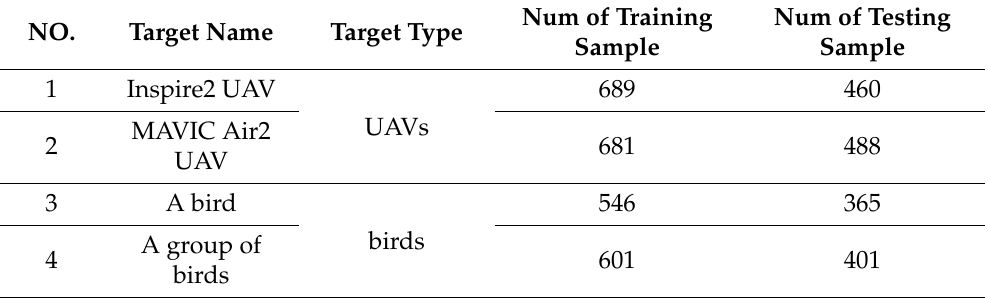
Table 2. Dataset specifications.